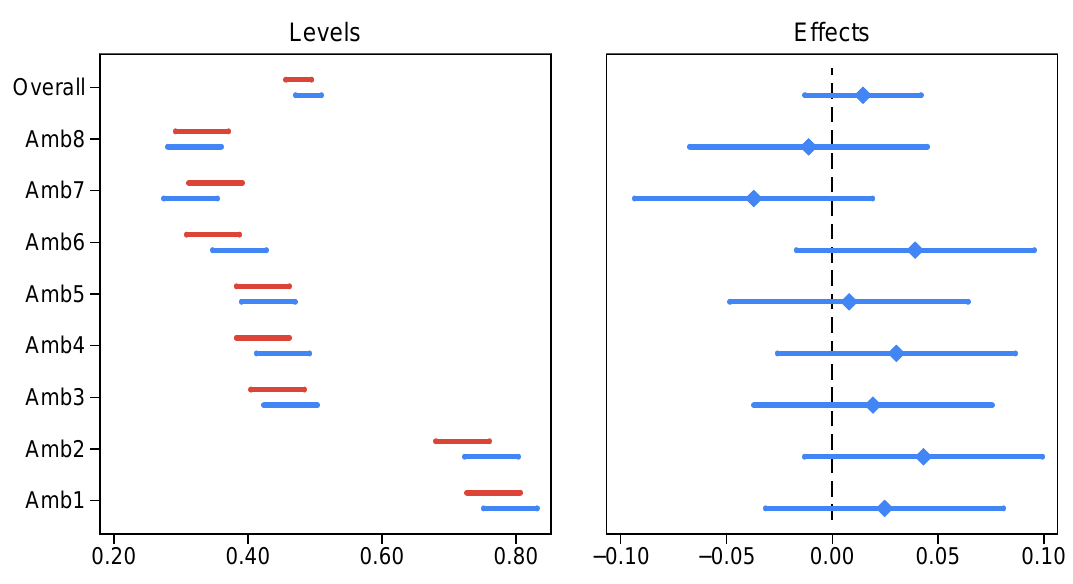
Figure 2: Ratings of migration background by treatment condition. The left panel displays the predicted probability that a phenotypically ambiguous profile is classified as having a migration background in the treatment and control groups. The right panel displays the estimated treatment effect and associated 95 percent confidence intervals. Full estimation results underlying these coefficients are reported in Table A2 of the online